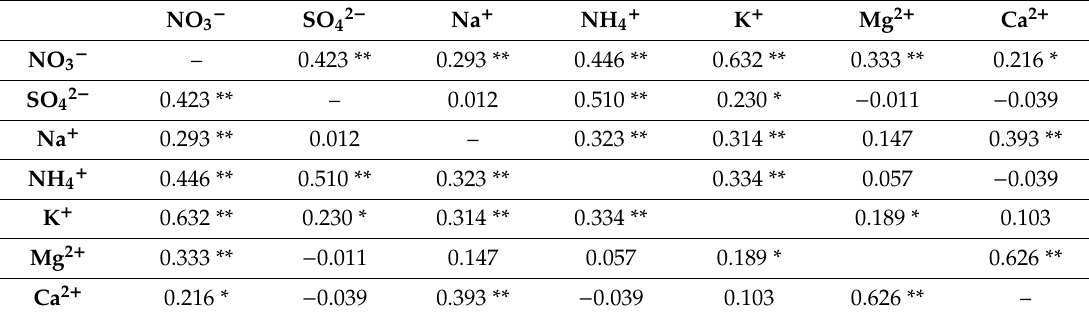
Table 5. Pearson correlation coe ffi cients between ionic constituents. Note that ** and * indicates the significant correlation at a significance level of 0.01 and 0.05,